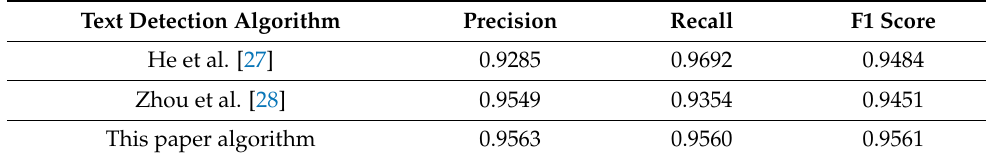
Table 2. Performance of different text detection